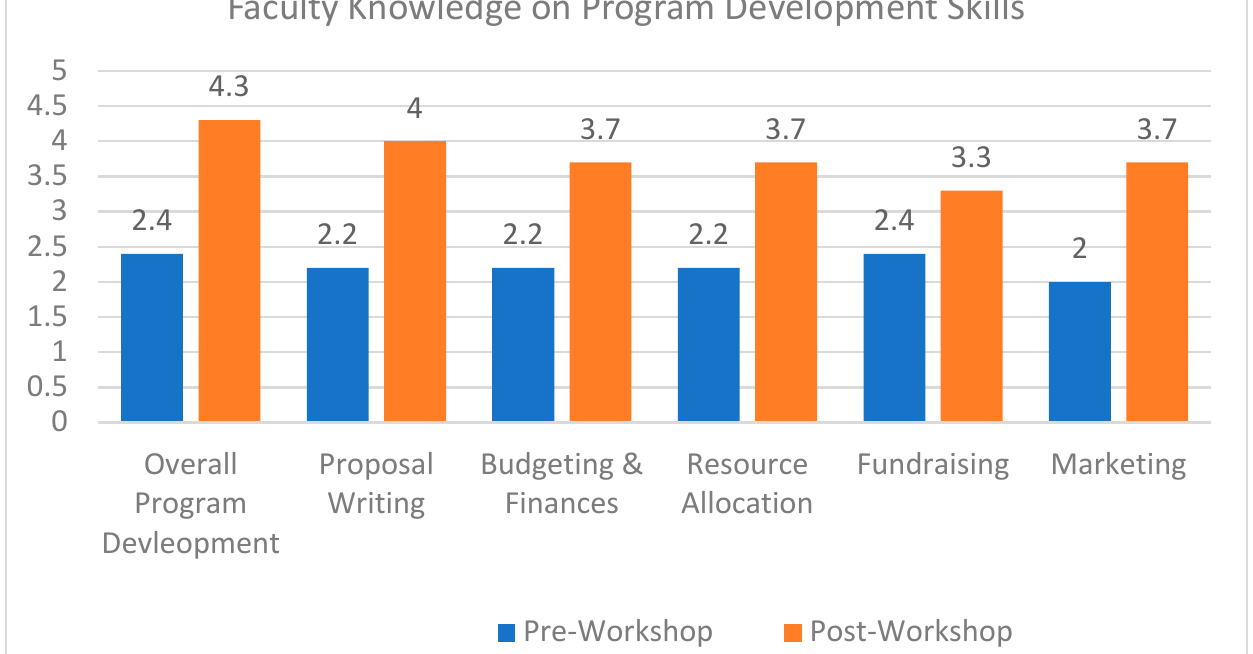
Figure 1. Faculty knowledge on program development skills. Faculty responses based on 5-point Likert scale with 5 being the most knowledge.